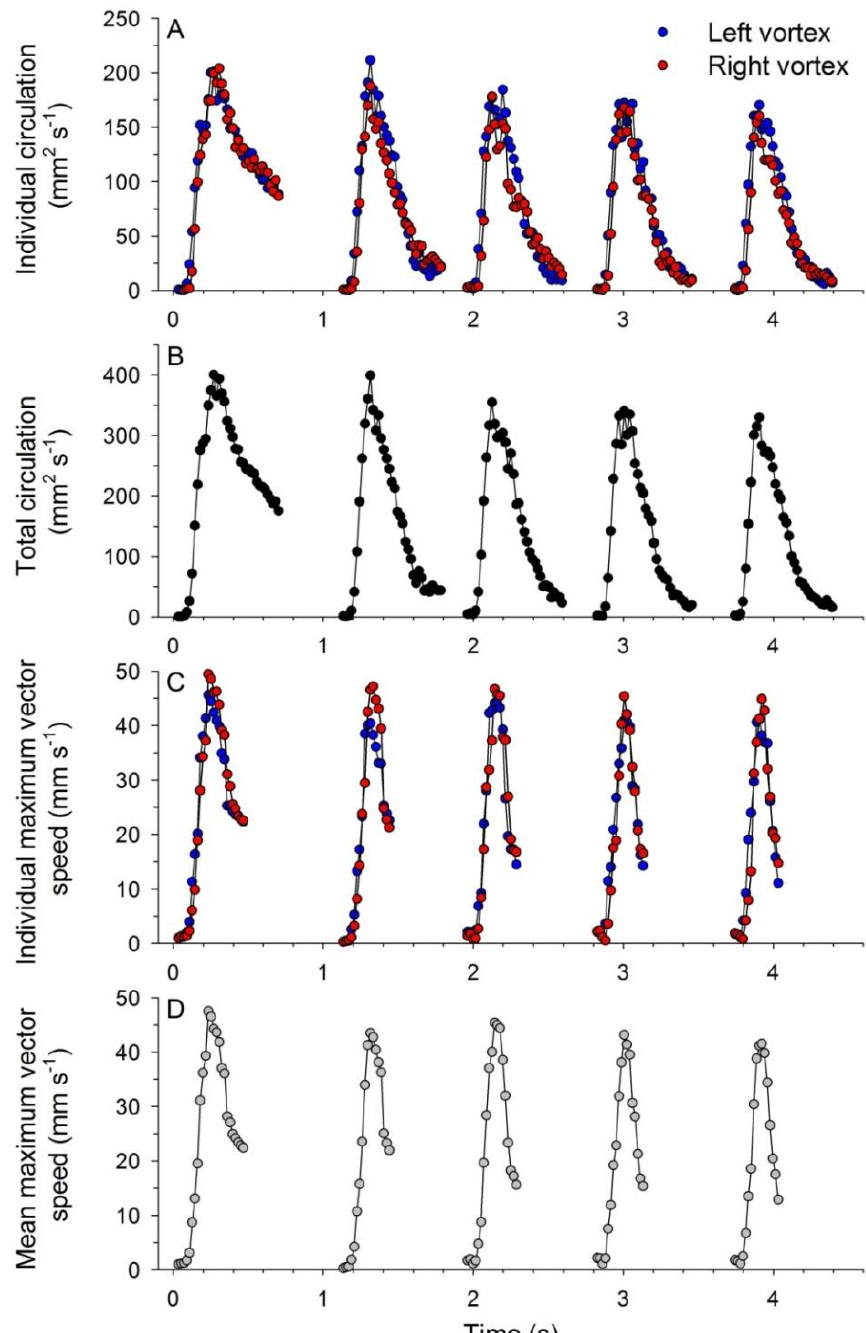
Figure 6. Vortex circulation and VIA magnitudes of starting vortices for consecutive bell pulsation cycles of a Eutonina indicans medusa swimming in a primarily linear direction. All data and animal images correspond to the pulsation cycles depicted in Figures 2 and 3. ( A ) Starting vortex circulation magnitude at either bell margin; ( B ) combined total circulation for the two margins; ( C ) maximum vector speeds along VIA transects for either side of the bell margin; and ( D ) mean values for the combined maximum VIA region velocities.